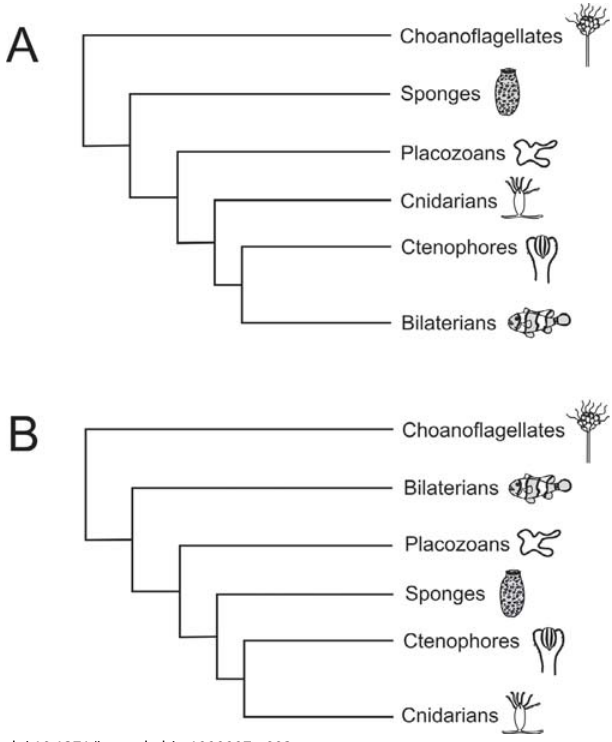
Figure 2. Schemata of Two Hypotheses for the Branching Order of Groups at the Root of the Metazoan Tree (A) One of several competing hypotheses for early metazoan evolution: the choanoflagellates (which are not animals; see Box 1) serve as an outgroup in the analysis, and sponges are the sister group to the placozoan + cnidarian + ctenophore + bilaterian clade (see [6]). (B) A simplified view of the hypothesis of Schierwater et al. [10]: bilaterians are the sister group to the placozoan + sponge + ctenophore + cnidarian clade, while placozoans are the sister group to the sponge + ctenophore + cnidarian clade. (Artwork courtesy of Austin